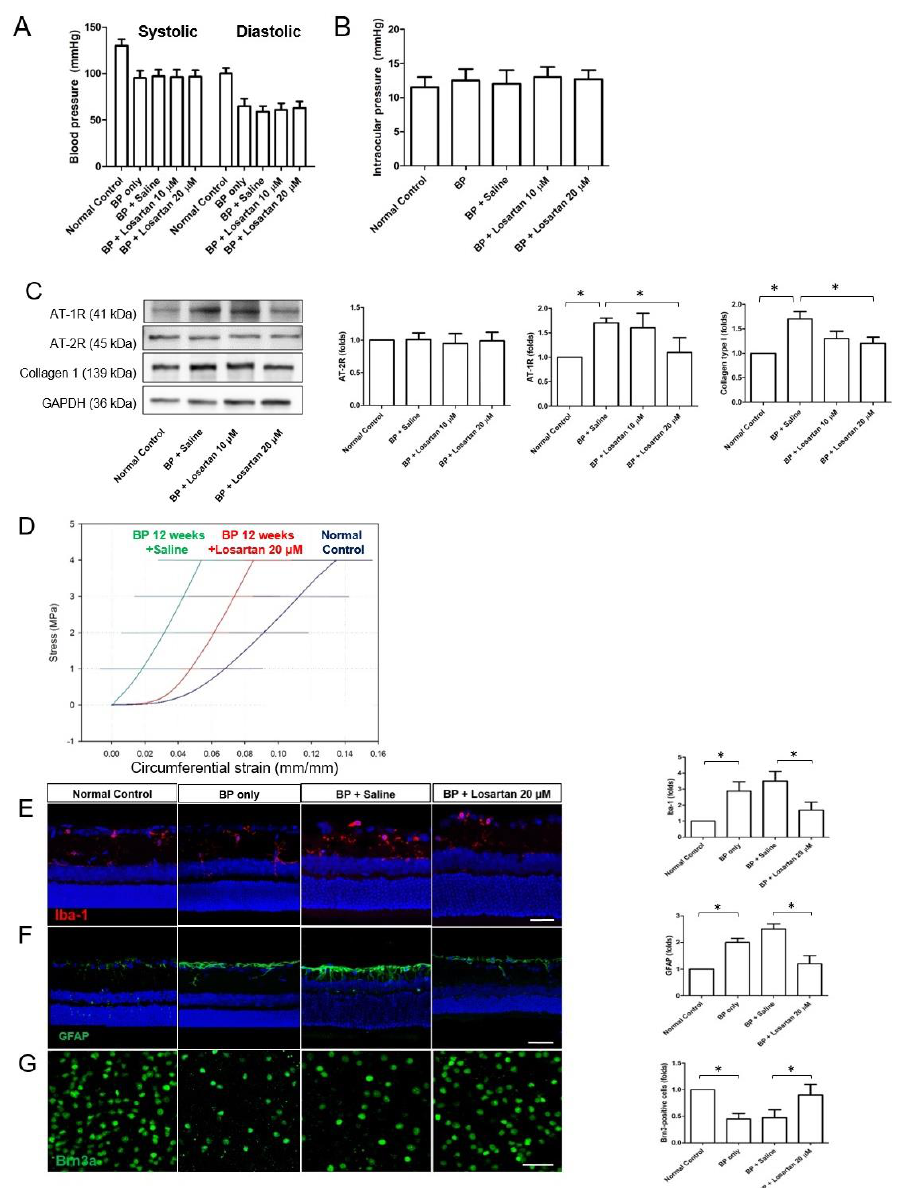
Figure 7. ( A , B ) Blood pressure and intraocular pressure of normal control, hypotension model (BP only), after sub-Tenon injection of saline, losartan 10 µ M, and 20 µ M. ( C ) Western blotting of Ang II receptors and collagen type I in normal control and after sub-Tenon injection of saline and losartan in the systemic hypotensive rats. The expression levels of AT-1R and collagen type I, but not AT-2R,